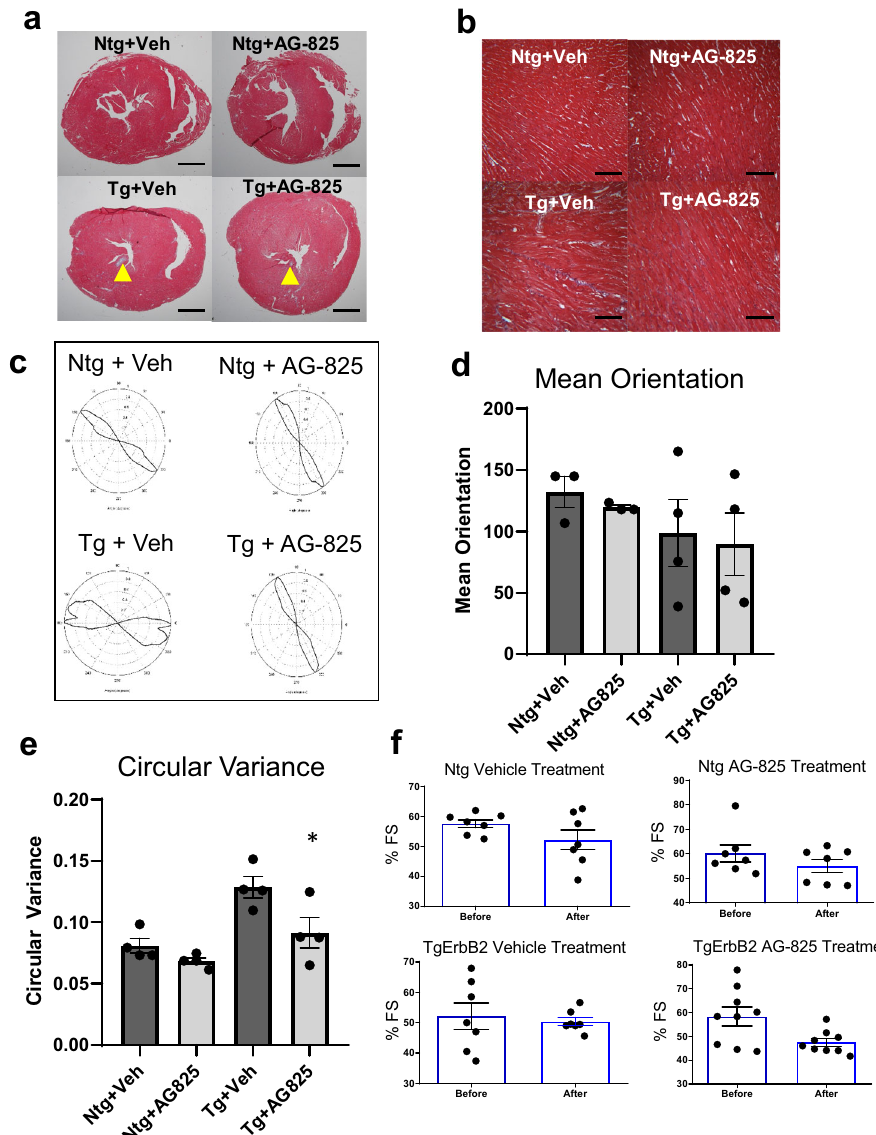
Fig. 7 Tyrosine kinase receptor inhibitor AG-825 reduces cardiac myocyte disarray without effects on contractile function in TgErbB2 mice. a Masson ’ s trichrome stained sections (5X) from vehicle-treated Ntg and AG-825 – treated Ntg and vehicle-treated TgErbB2 and AG-825-treated TgErbB2 mice, yellow arrowheads point to fi brotic areas. Scale bar 1 mm. b Masson ’ s trichrome stained sections (40X) from representative regions of interest show increased Fibrosis in TgErbB2 mice myocardium, that fi brosis improved after 2 weeks of AG-825 Treatment. The same areas were used to determine the level of cardiac myocyte disarray, which was achieved by analyzing cell orientation using CytoSpectre Software from Vehicle and AG-825 treated Ntg and TgErbB2 mouse heart sections (scale bar 50 μ m). c Plots of the distribution of cardiac cells orientation angles. Note how Ntg angles are homogeneous and did not change in the group treated with AG-825. In contrast, Tg treated with vehicle showed less homogenous and different orientation angles, con fi rming cardiomyocyte disarray. AG-825 Treatment reduces cardiomyocyte disarray, and the orientation plot is similar to the AG-825 treated NTG group. d Mean orientation angle of cardiac myocytes, and e Circular variance, another measure of isotropy, in Ntg and TgErbB2 mice with and without AG-825 treatment ( n = 5 animals per condition). Graph bars are expressed as mean ± s.e.m.; a one-way ANOVA test was performed for statistical comparisons showing a signi fi cant improvement in TgErbB2 mice treated with AG-825 ( p -value < 0.0014). f Cardiac echocardiography from the four groups shows that AG-825 Treatment for 14 days did not modify the contractile function, estimated as % Fraction